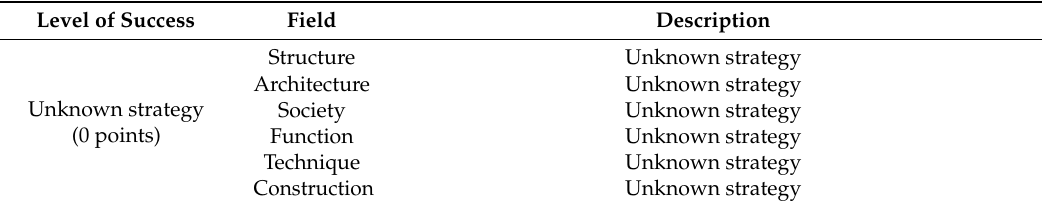
Table 3. Definition of the levels of